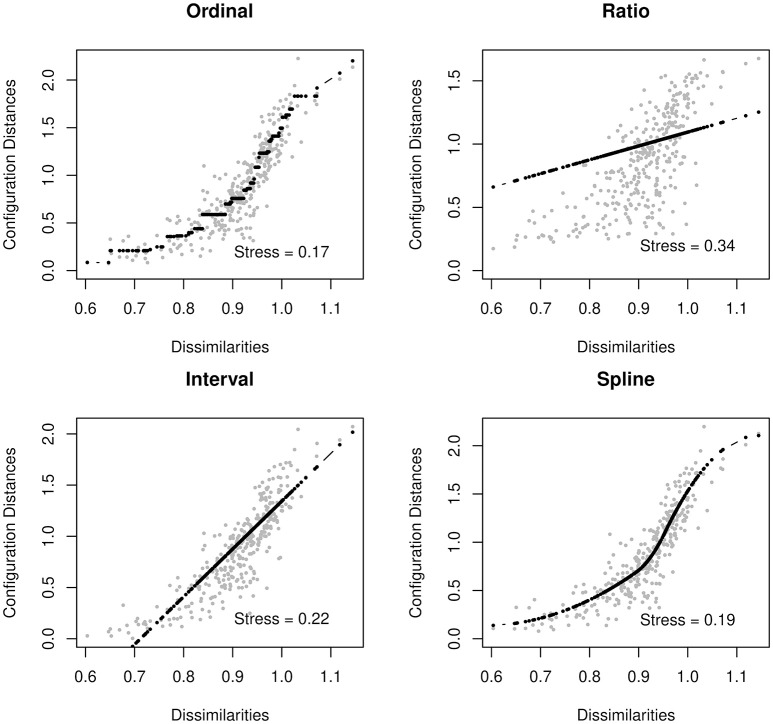
Shepard Diagrams.